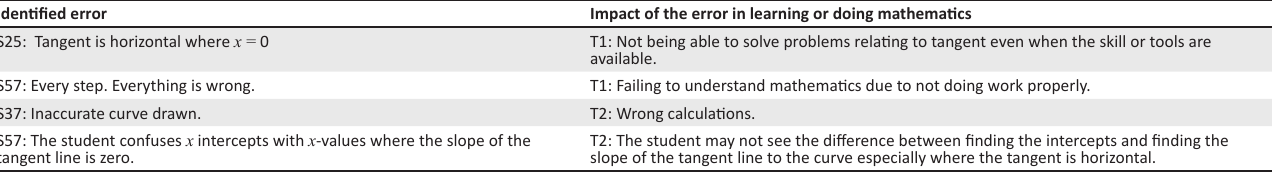
TABLE 1: Identified errors with corresponding teachers’ evaluation. Identified error